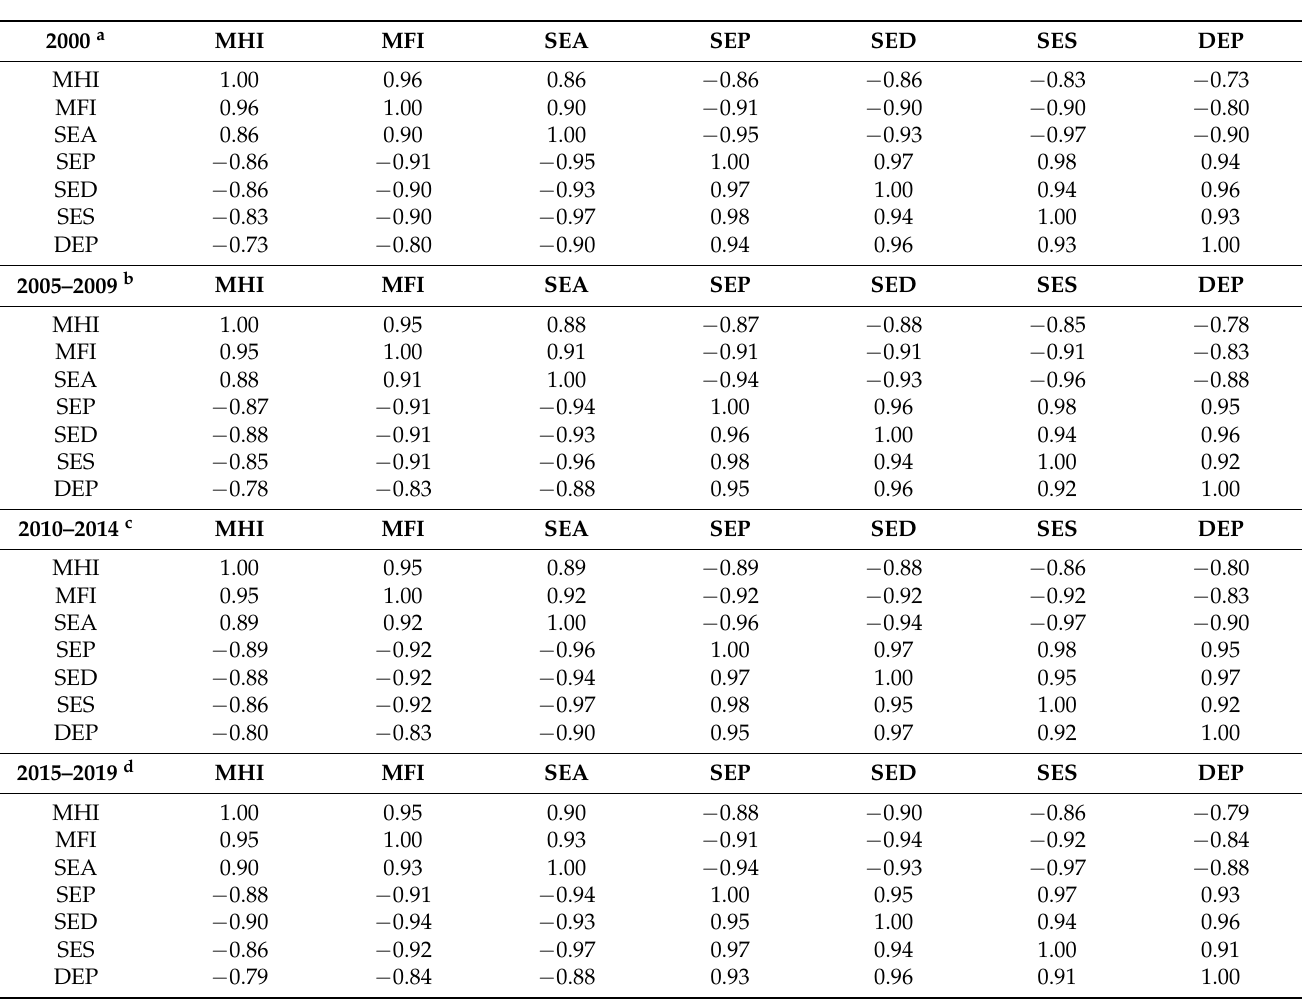
Table 9. Relationships between simple and composite measures of neighborhood socioeconomic status in the San Jose–Sunnyvale–Santa Clara Metropolitan Statistical